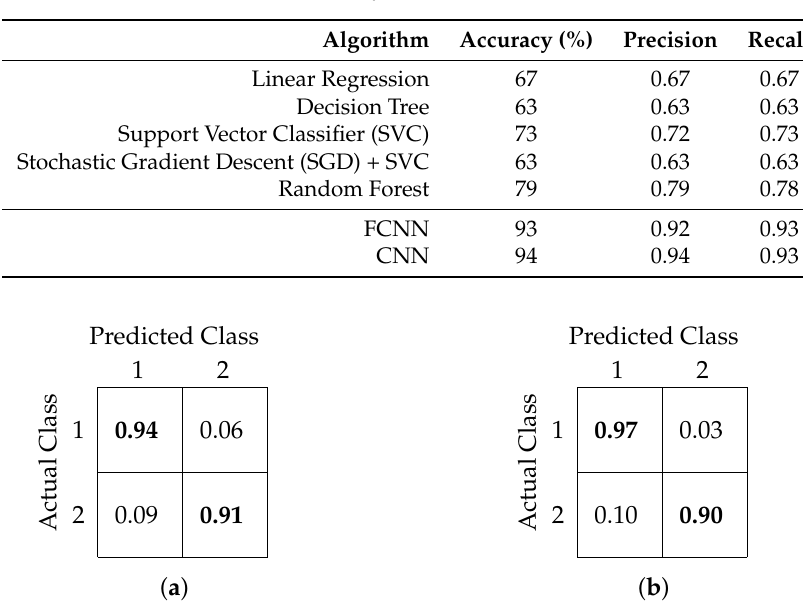
Table 2. Binary classification results.